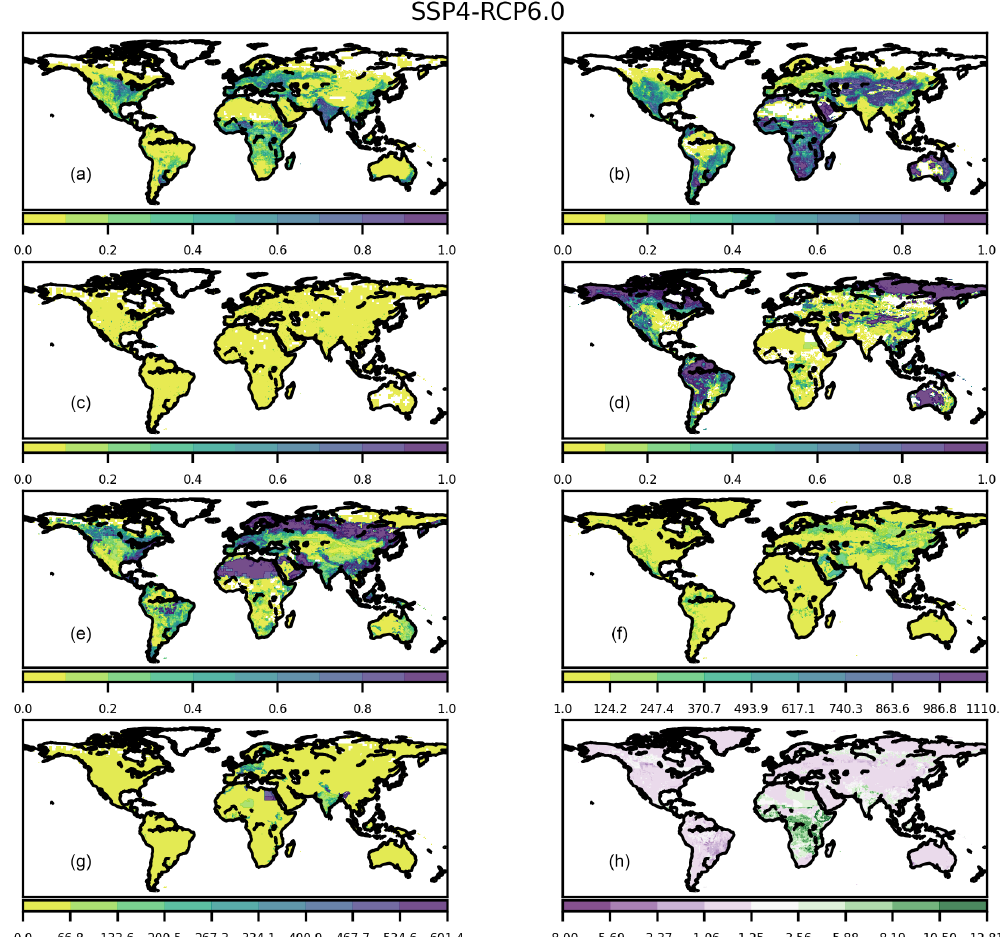
Figure A1. Maps for the year 2100 for the SSP4-RCP6.0 scenario showing the following: (a) the fraction of each grid cell occupied by cropland; (b) the fraction of each grid cell occupied by pasture; (c) the fraction of each grid cell occupied by urban land; (d) the fraction of each grid cell occupied by primary vegetation; (e) the fraction of each grid cell occupied by secondary vegetation; (f) the mean age (in years) of secondary lands in each half-degree grid cell; (g) the mean gross transitions (km 2 yr − 1 ) over a 20-year interval for each grid cell; and (h) the mean net transitions (km 2 yr − 1 ) over a 20-year interval for each grid